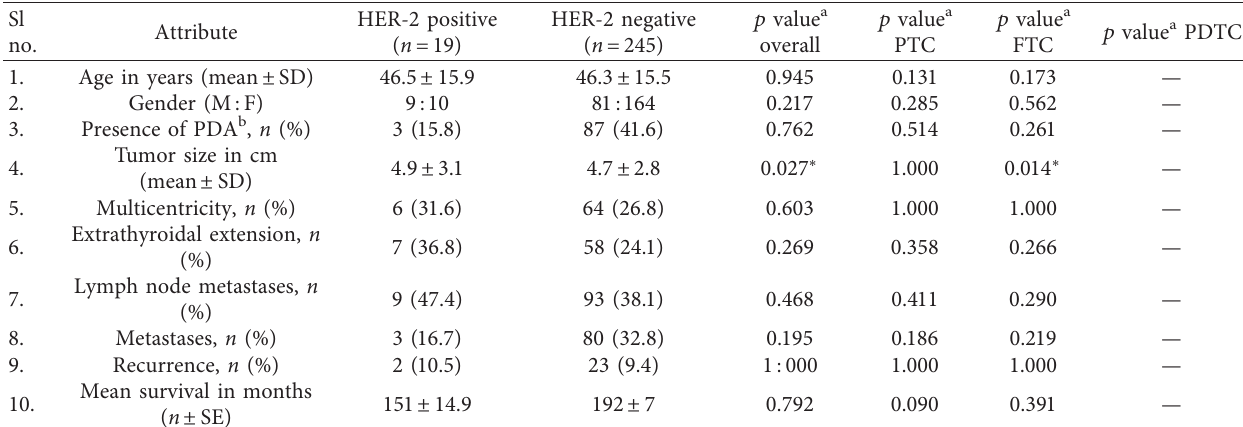
Table 3: Clinicopathologic correlation of HER-2.